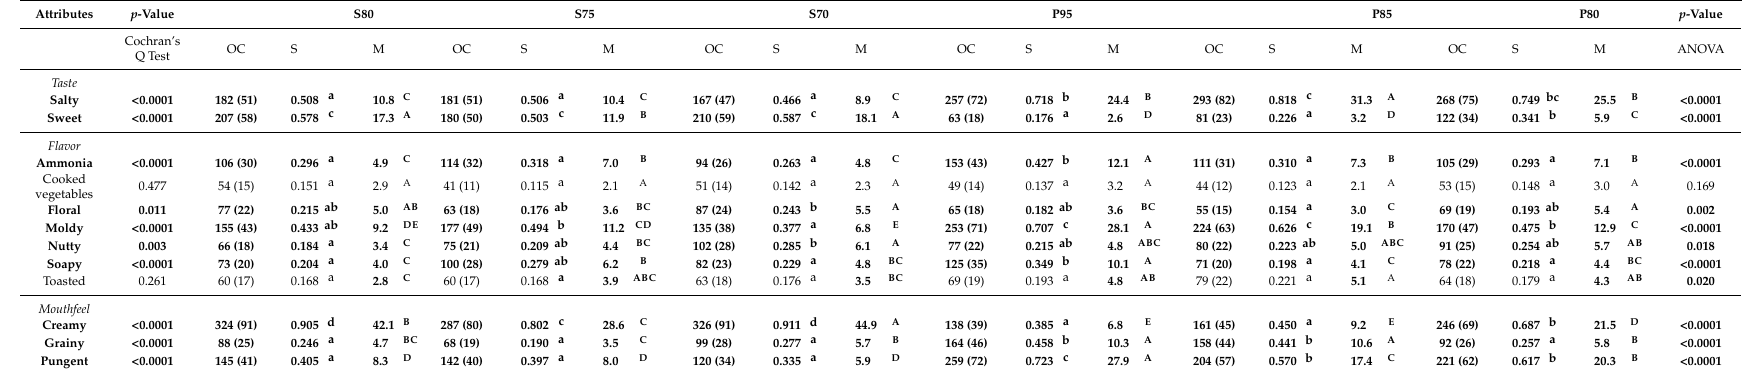
Table 3. Sensory attributes selected for the Gorgonzola cheese products by consumers during the RATA test. For each attribute was reported: the Cochran’s Q test p -value, the occurrences (OC, percentage in brackets), the significance values from the multiple pairwise comparison tests (Sheskin, S), the means of the intensity scores (M), and the p -value from the two-way ANOVA